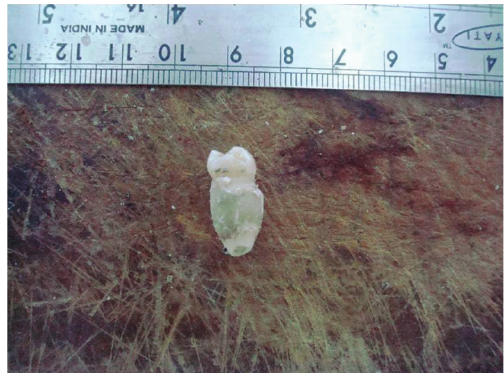
Figure 1: Gross Specimen showing dilation of root.